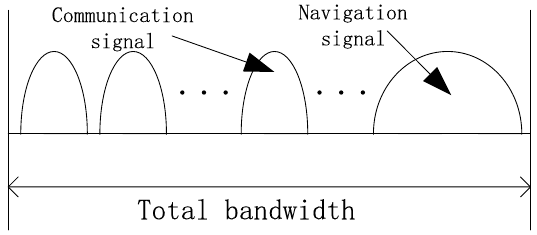
Figure 3. The PSD of signal by generated method 3.